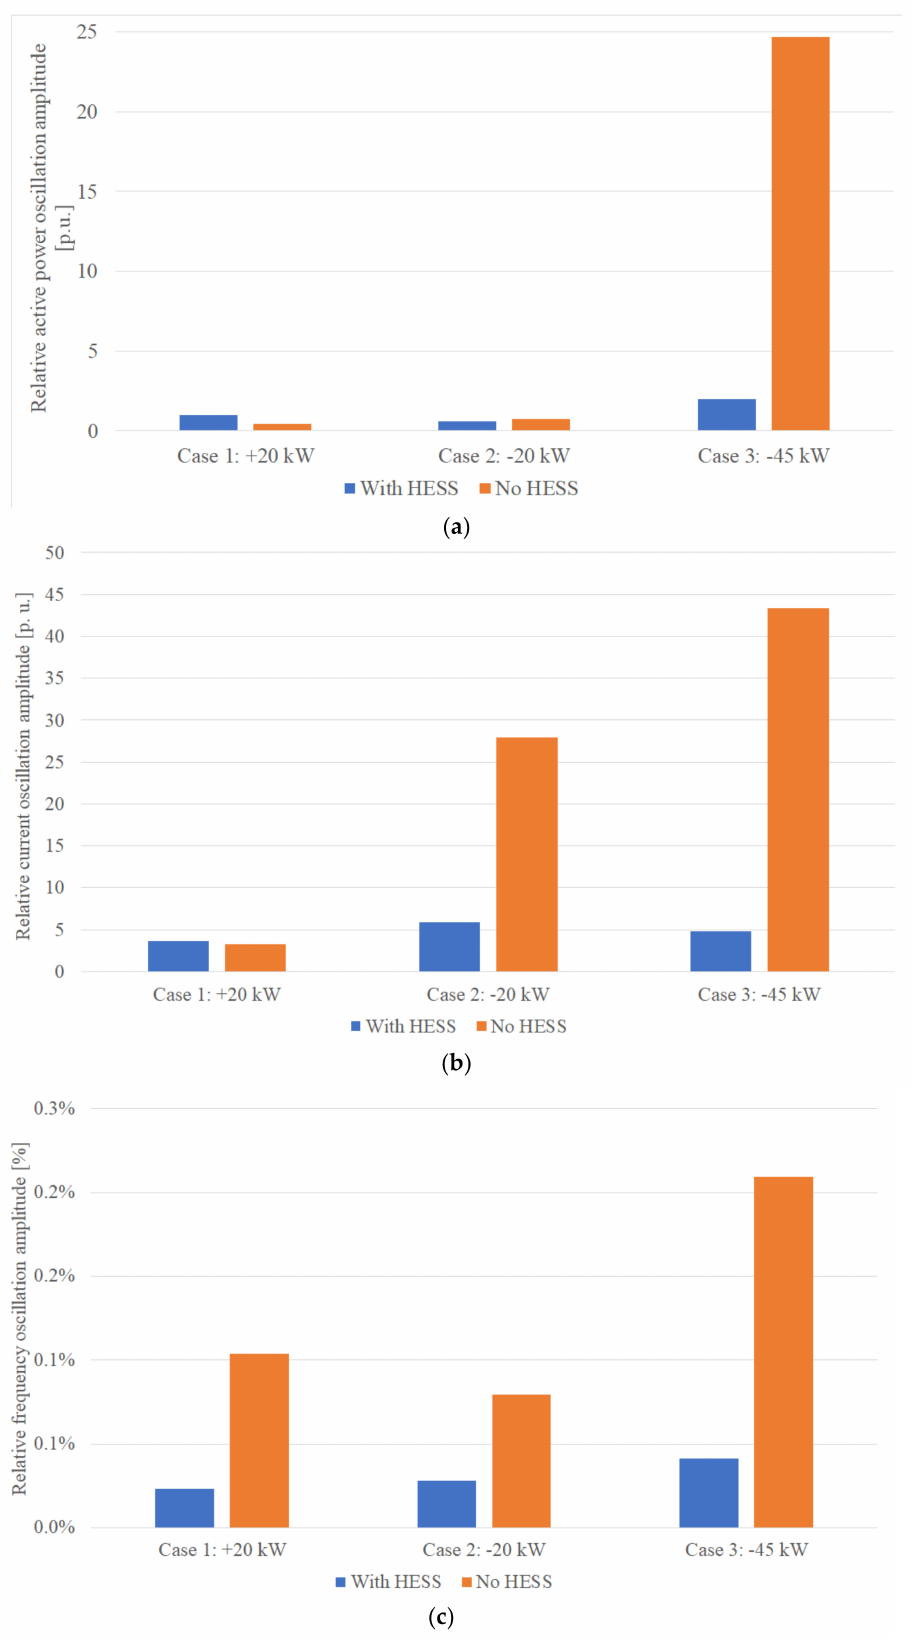
Figure 11. Relative oscillations amplitudes for the three studied cases, with respect to ( a ) active power (p.u.), ( b ) current (p.u.), ( c ) frequency (in